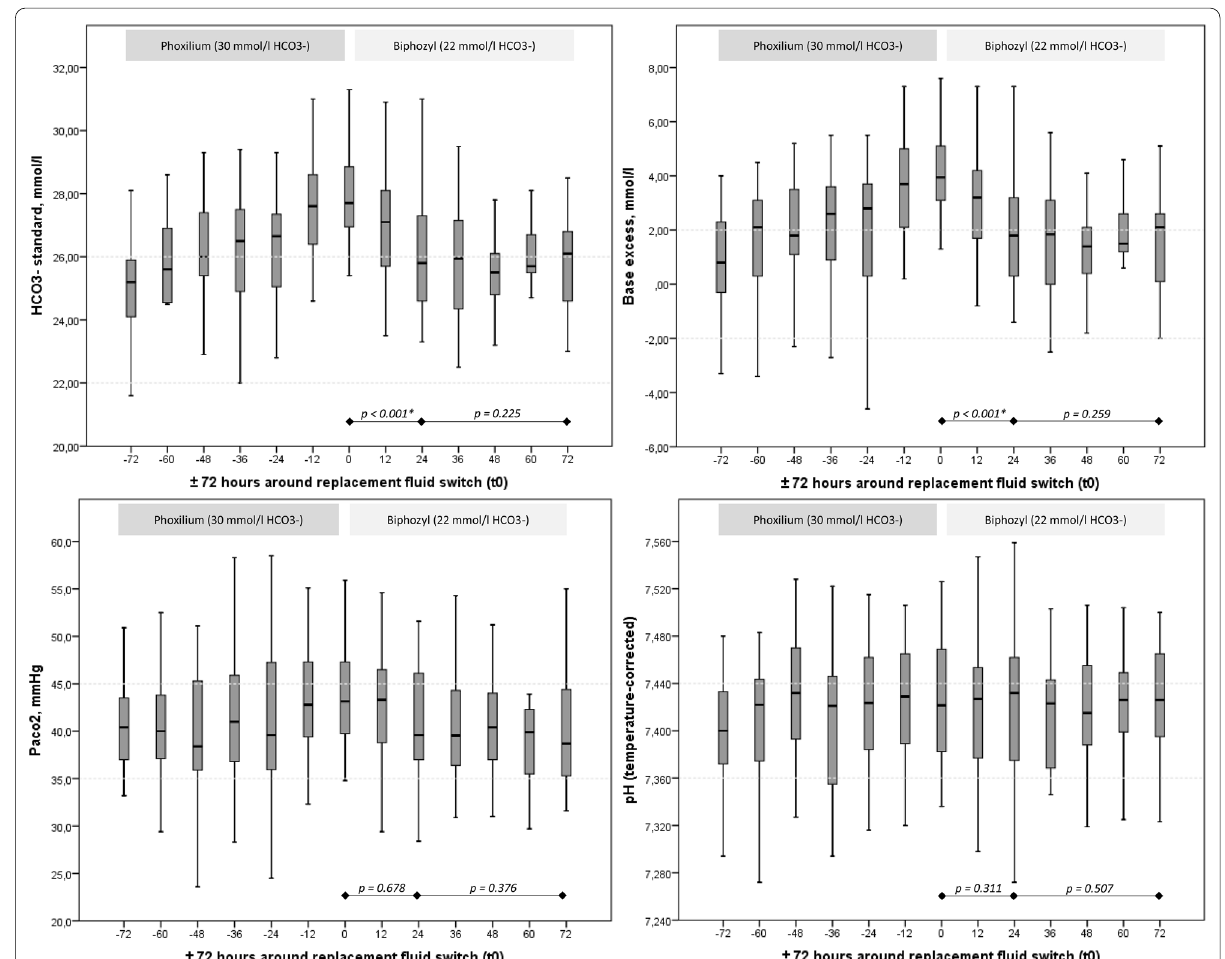
Fig. 2 Time course of HCO 3 − , BE, PaCO 2 and pH over 72 h before and after switching (0 h) the replacement fluid from Phoxilium ® to Biphozyl